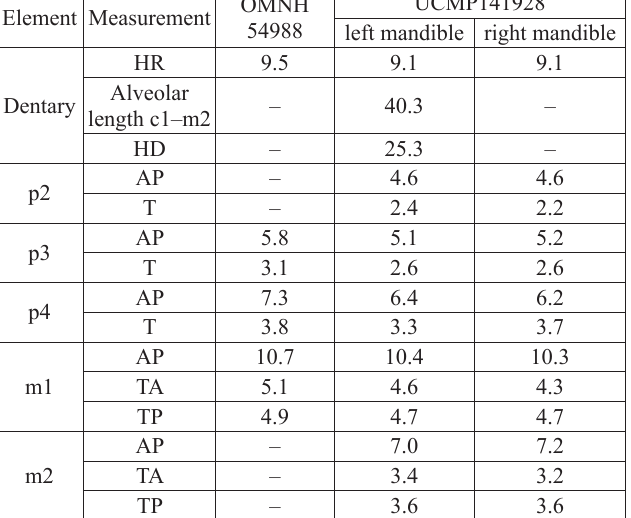
Table 3. Measurements (in mm) of Actiocyon parverratis sp. nov., dentaries and teeth from Eastgate, Nevada, USA; lower Monarch Mill Formation, Barstovian (Miocene). Abbreviations: AP, anteroposterior length; HD, height of dentary from bottom of horizontal ramus to top of coronoid process; HR, depth of horizontal ramus below m1 protoconid; T, greatest transverse width; TA, anterior width (trigonid width of lower molars); TP, posterior width (talonid width of lower molars).